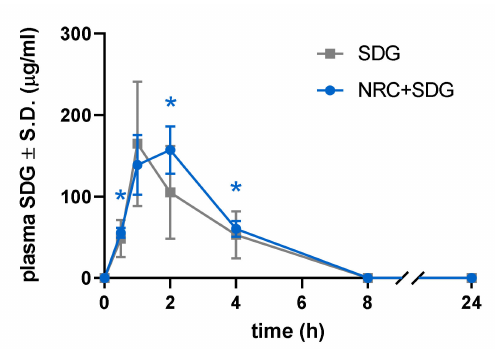
Figure 1. Plasma SDG levels significantly increase after a painful nerve root compression (NRC + SDG), as compared to levels at baseline (0 h, 0.5 h (* p = 0.0157), 2 h (* p = 0.0443) and 4 h (* p = 0.0329) after a subcutaneous injection. The levels do not di ff er from levels in naïve rats